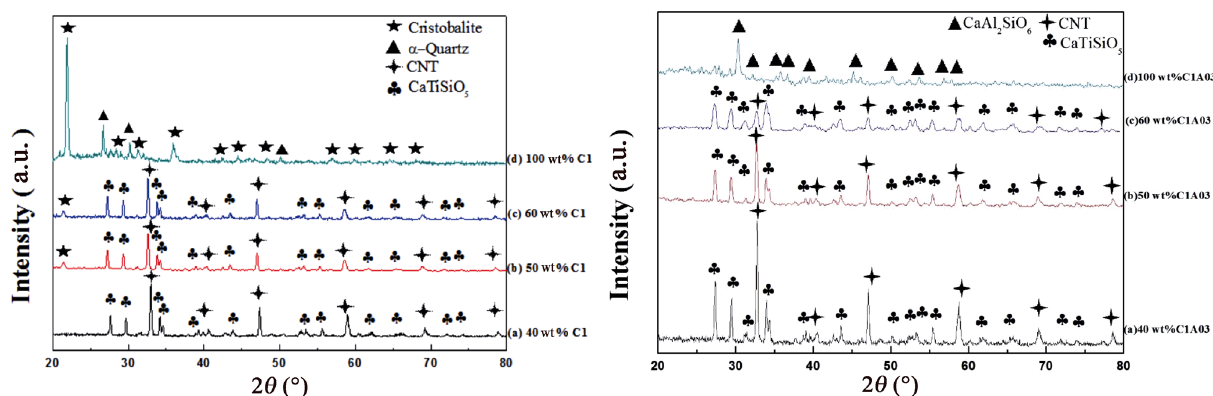
Fig. 1 XRD patterns of Ca 0.7 Nd 0.2 TiO 3 powders added with 40, 50, and 60 wt% C1 and C1A03 glass powders after sintering at 900 ℃ for 1 h.